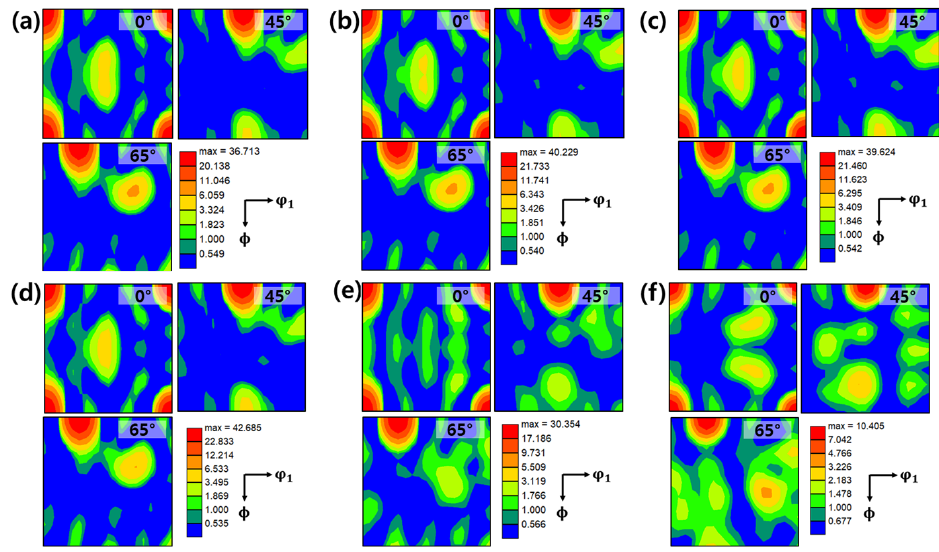
Figure 3. Orientation distribution function plot of the ( a ) cold-rolled, ( b ) 400 °C, ( c ) 500 °C, ( d ) 700 °C, ( e ) 800 °C, and ( f ) 900 °C heat-treated specimens.